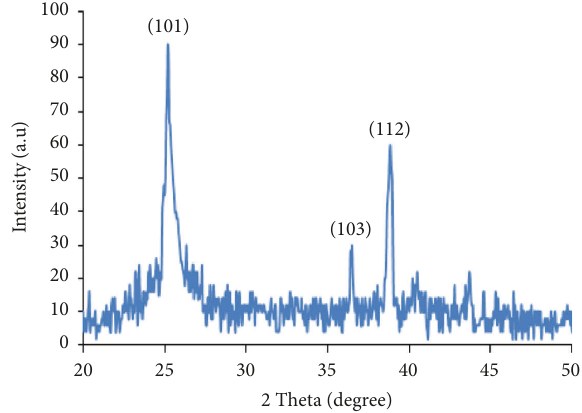
Figure 1: XRD pattern of TiO